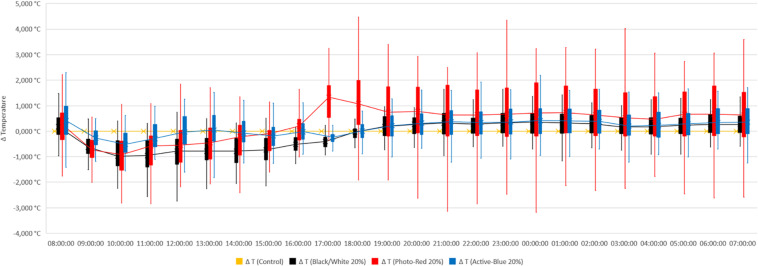
Temperature recorded under photo-selective nets during winter (from June to end of August). Data were collected hourly. Temperature is expressed as difference between temperatures recorded under the nets and in open field (control). The horizontal middle line represents the median that goes through the mean of each box. The whiskers (vertical lines) extend from the ends of the box to the minimum value and maximum value.